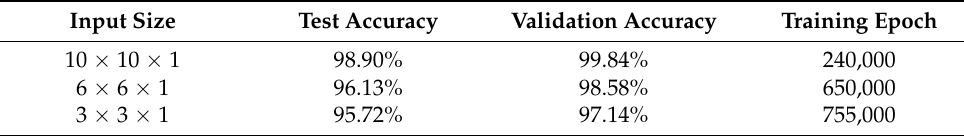
Table 4. Test accuracy results for EPSON IMU gyroscope.